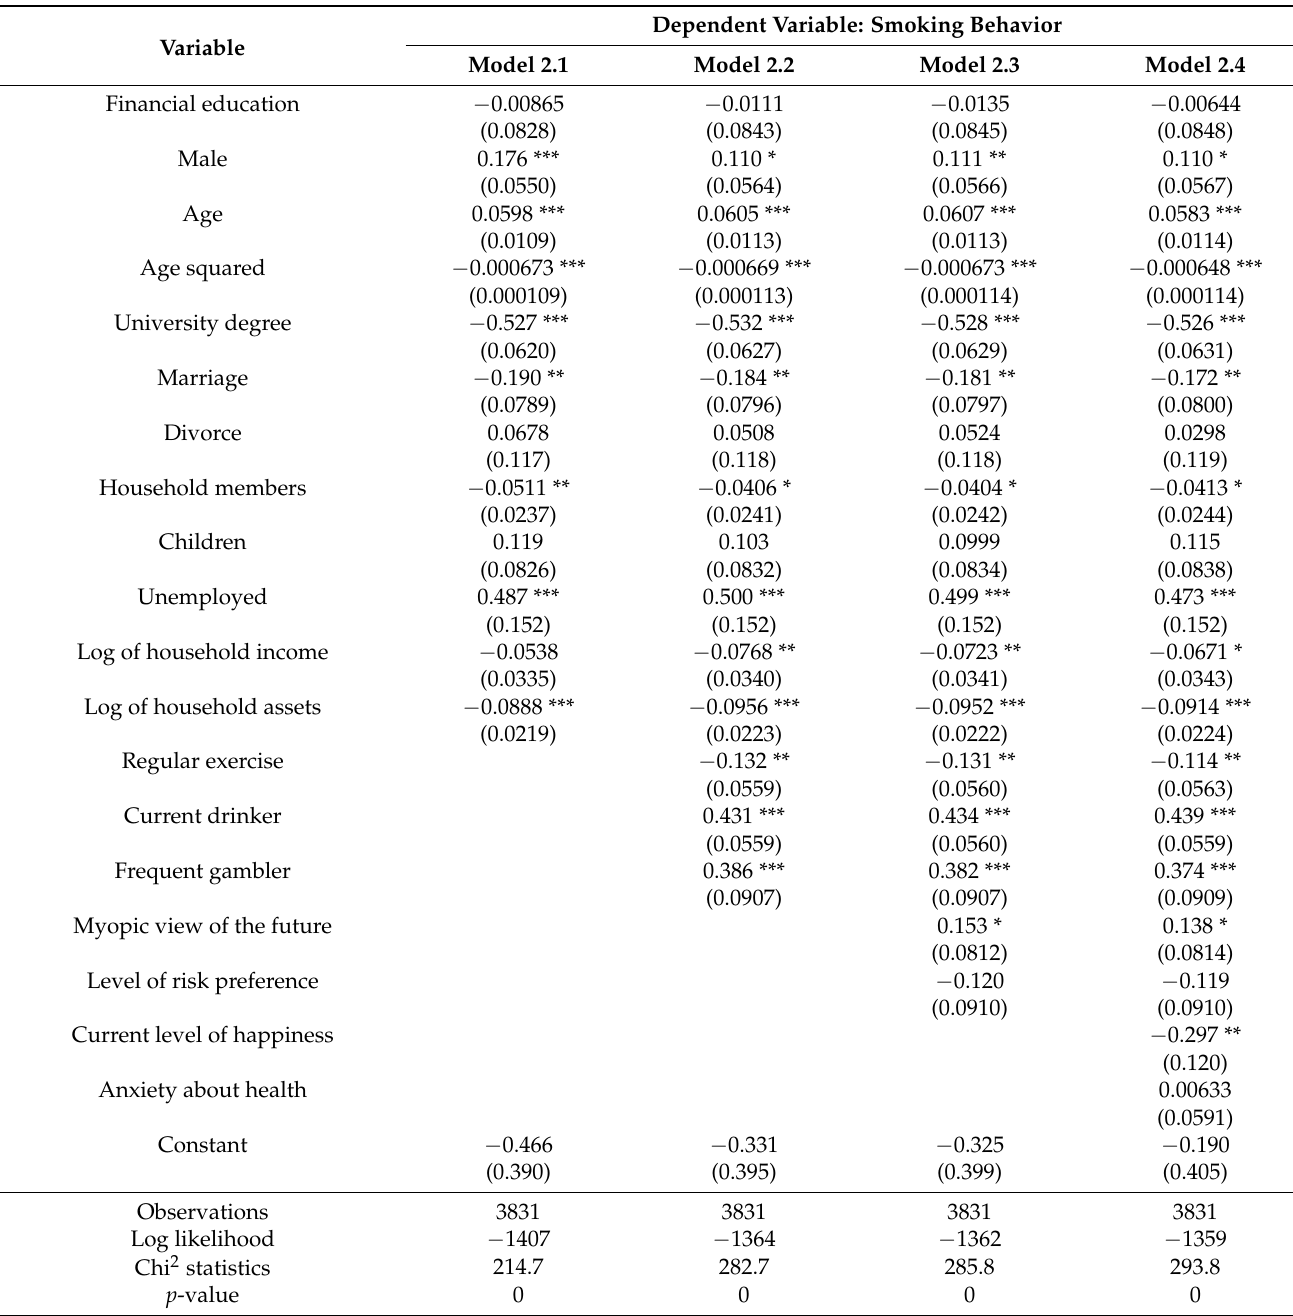
Table 7. Probit model regression results: financial education as the main explanatory